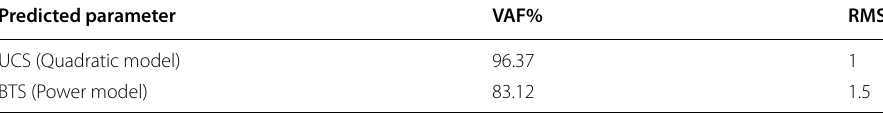
RMSE root mean square error, VAF % value account